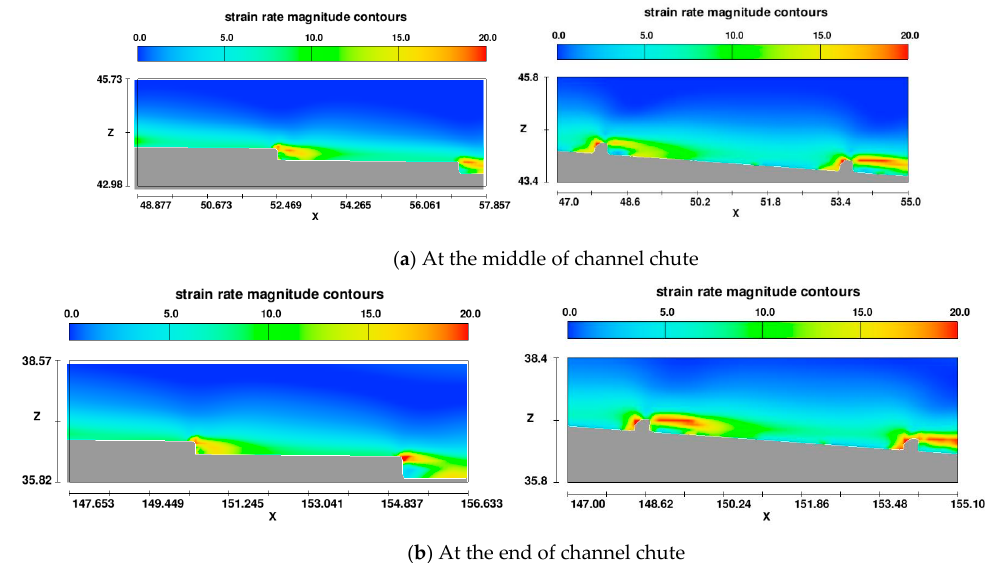
Figure 17. Strain rate magnitude for two abutment types when Z up = 55.86 m and Q = 3319 m 3 /